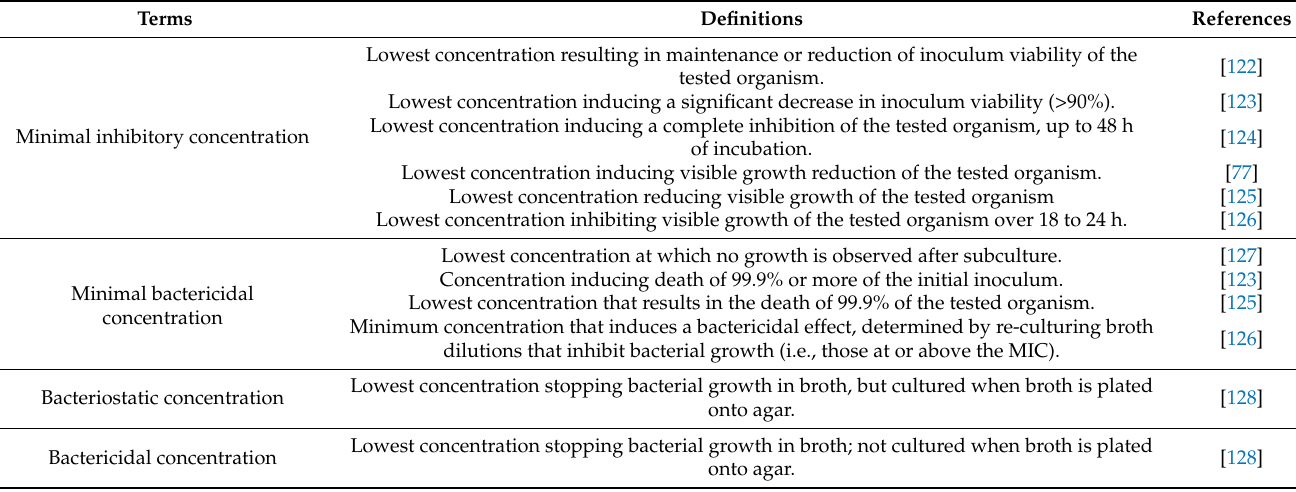
Table 2. Terms used to define the antimicrobial activities of essential